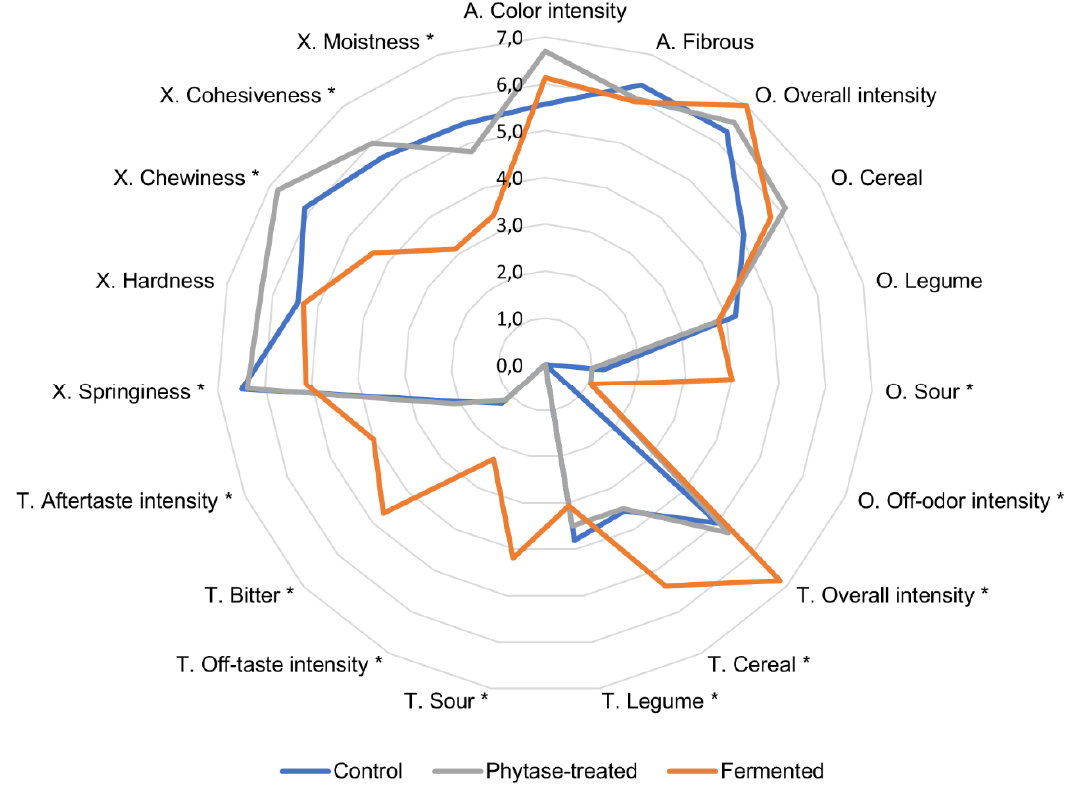
Figure 5. Sensory analysis of extrudates. Here, A means appearance, O—odor, T—taste, and X—texture. An asterisk indicates a statistically significant difference between the control and the fermented sample.